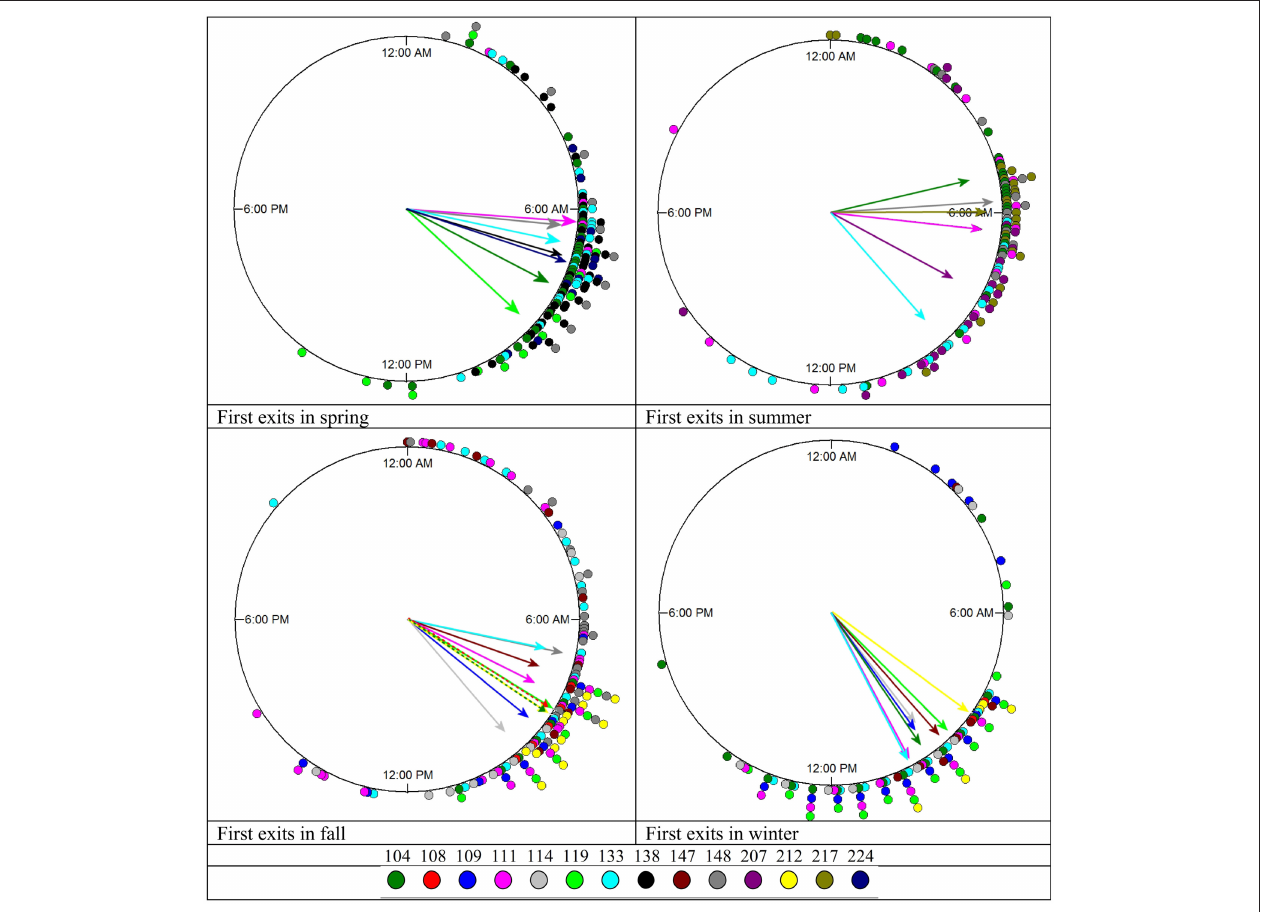
FIGURE 7 | Timing of first exits in individual squirrels during each season. The mean vectors point at the average timing of first entries for each squirrel and are in the same color as the data points plotted on the periphery of the circle (see the color key on the bottom). The length of the mean vector indicates how concentrated or spread the first exits are around this mean time. The exact values can be found in Table 3